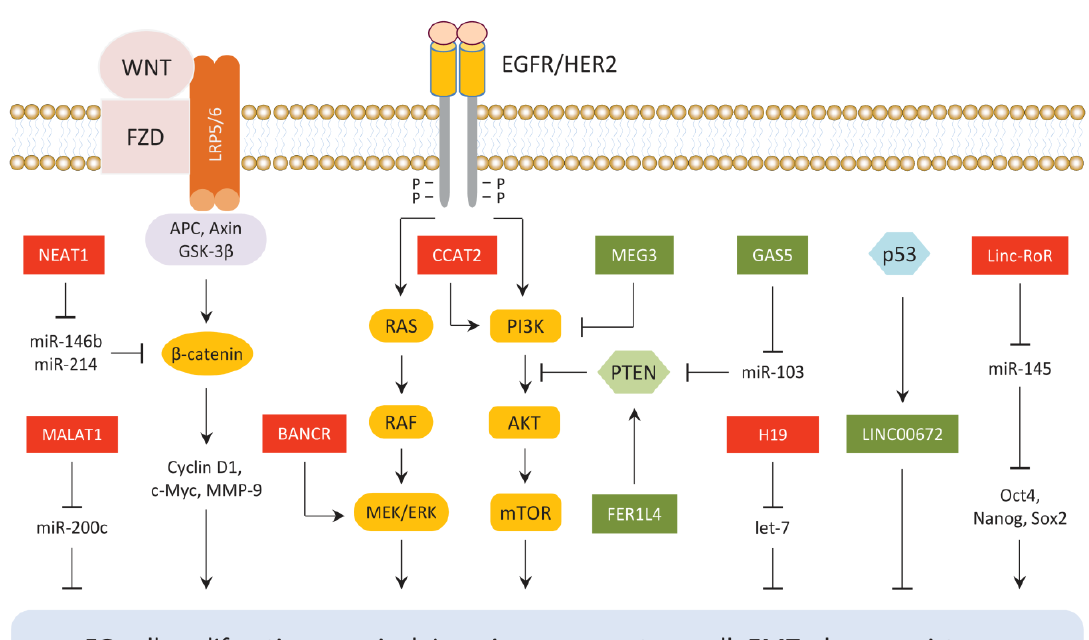
Figure 1. LncRNAs mediate cell signaling in EC cells. Tumor suppressive lncRNAs (GAS5, MEG3, FER1L4 and LINC00672) and oncogenic lncRNAs (CCAT2, BANCR, NEAT1, MALAT1, H19 and Linc-RoR) are upstream modulators or downstream effectors of well-known oncogenic or tumor suppressor pathways in EC, including the PTEN/PI3K/AKT/mTOR, RAS/RAF/MEK/ERK, WNT/β -catenin and p53 signaling pathways. Oncogenic lncRNAs (red) and tumor suppressive lncRNAs (green).